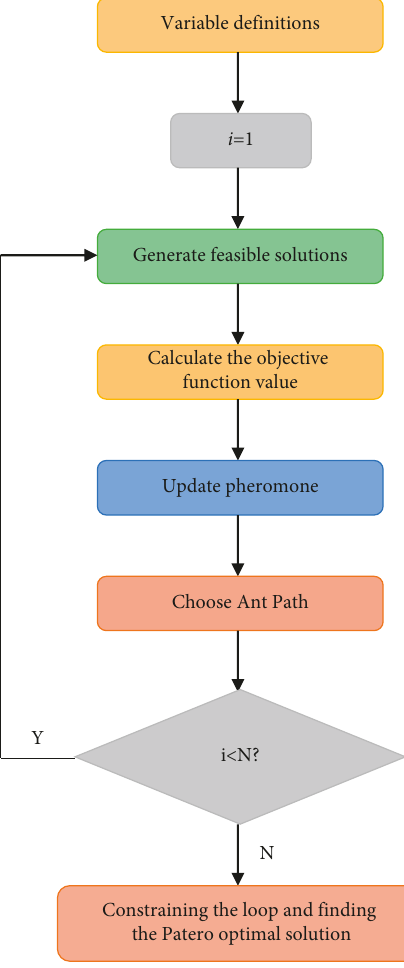
Figure 2: Ant algorithm